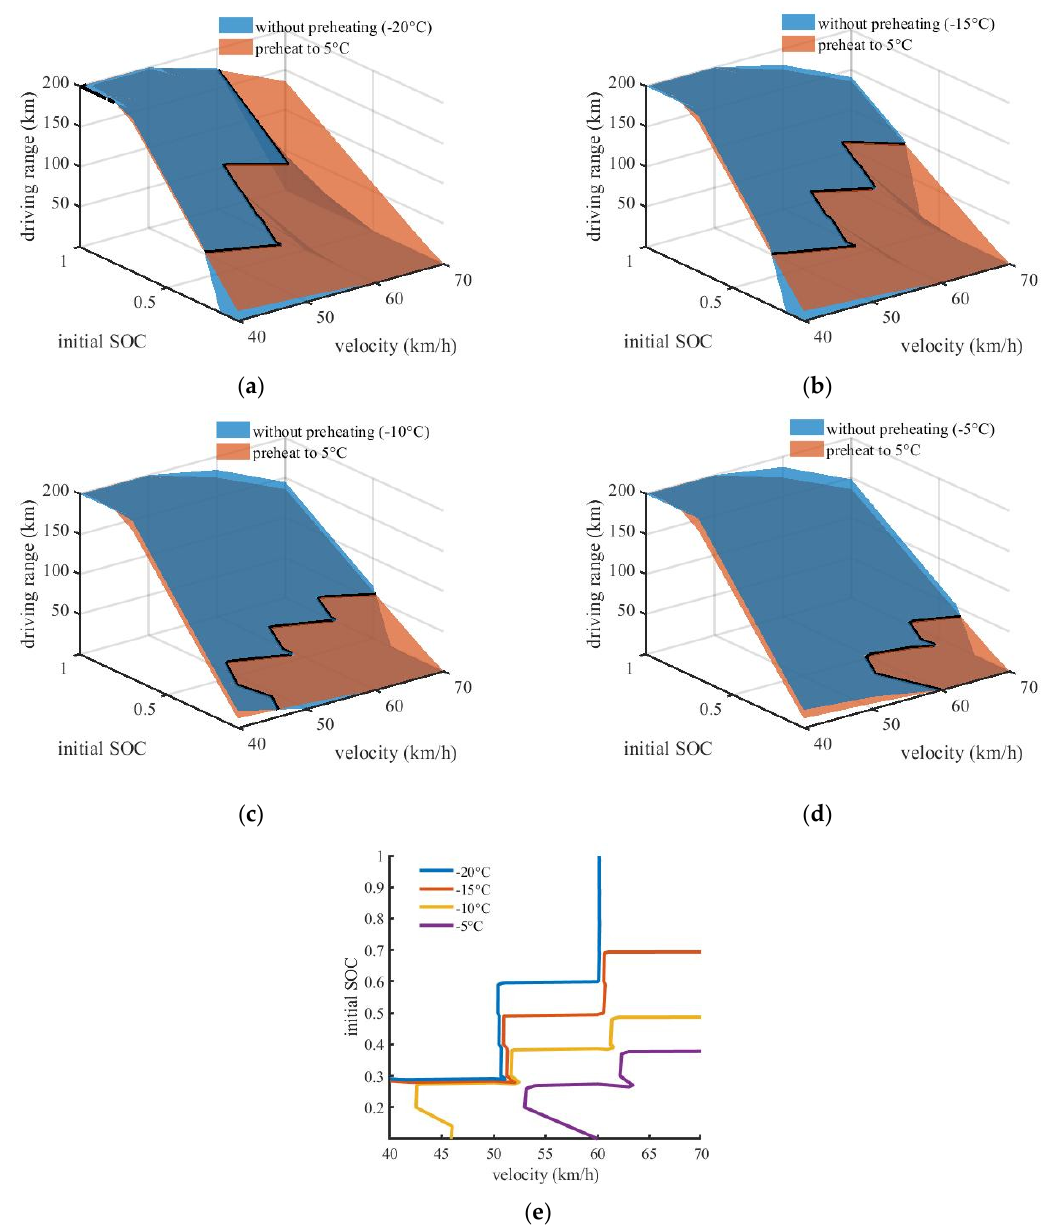
Figure 11. Simulation under constant speed driving conditions: ( a ) ambient temperature is − 20 °C; ( b ) ambient temperature is − 15 °C; ( c ) ambient temperature is − 10 °C; ( d ) ambient temperature is − 5 °C; and ( e ) heating boundary of each ambient temperature.